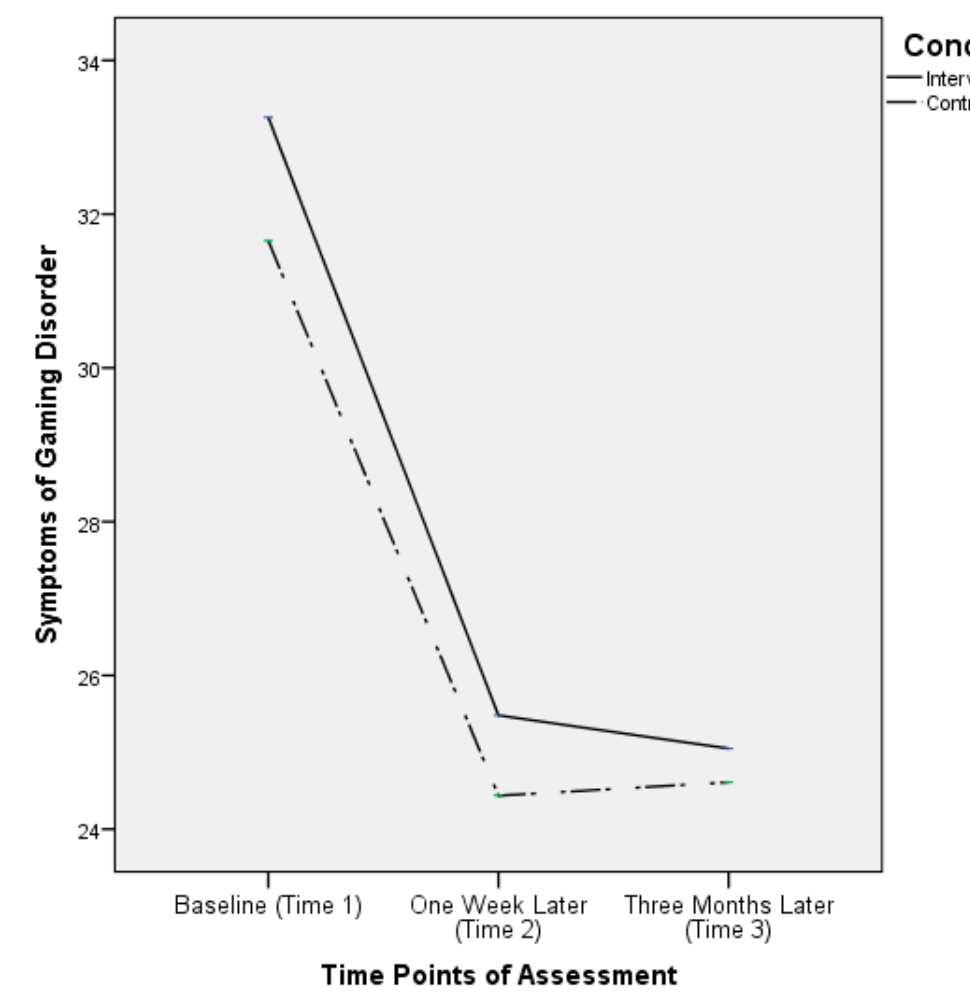
Figure 3. Parent report of children’s gaming disorder symptoms by time and condition.